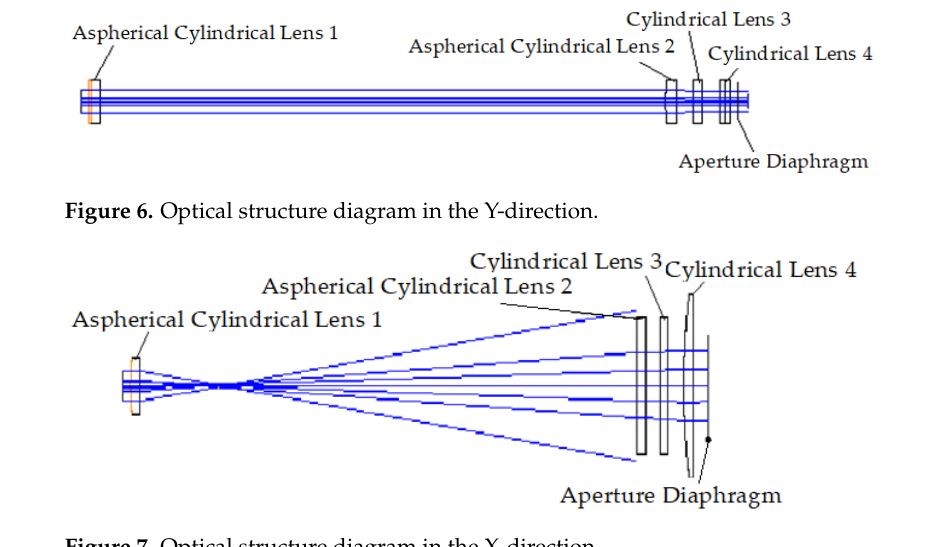
Figure 7. Optical structure diagram in the X-direction.